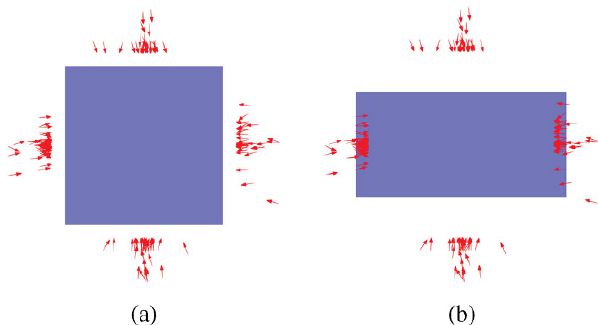
Fig. 1 Transferring a model for relative placement and orientation between object types “table” and “chair”. (a) Training data with a square table. (b) For a table of a different shape, the model needs to be